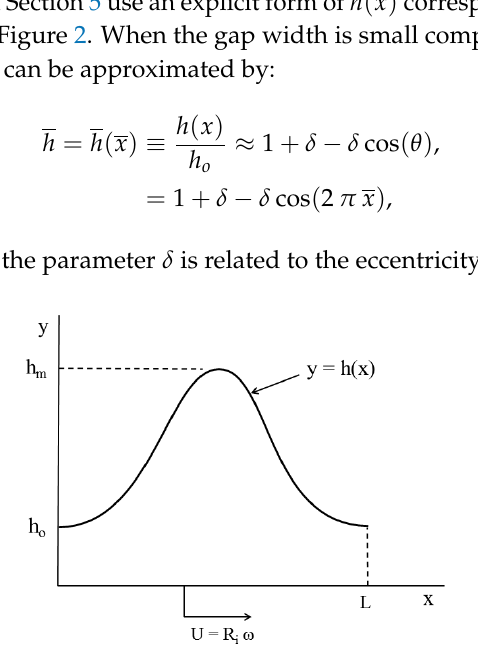
Figure 3. Unwrapped configuration: The surface y = 0 corresponds to the surface of the inner cylinder, i.e., the rotor. The surface y = h ( x ) corresponds to the surface of the outer cylinder, i.e., the stator. The minimum film thickness is taken to be h o ≡ h(0), and the maximum film thickness is taken to be h m ≡ h ( L /2 )